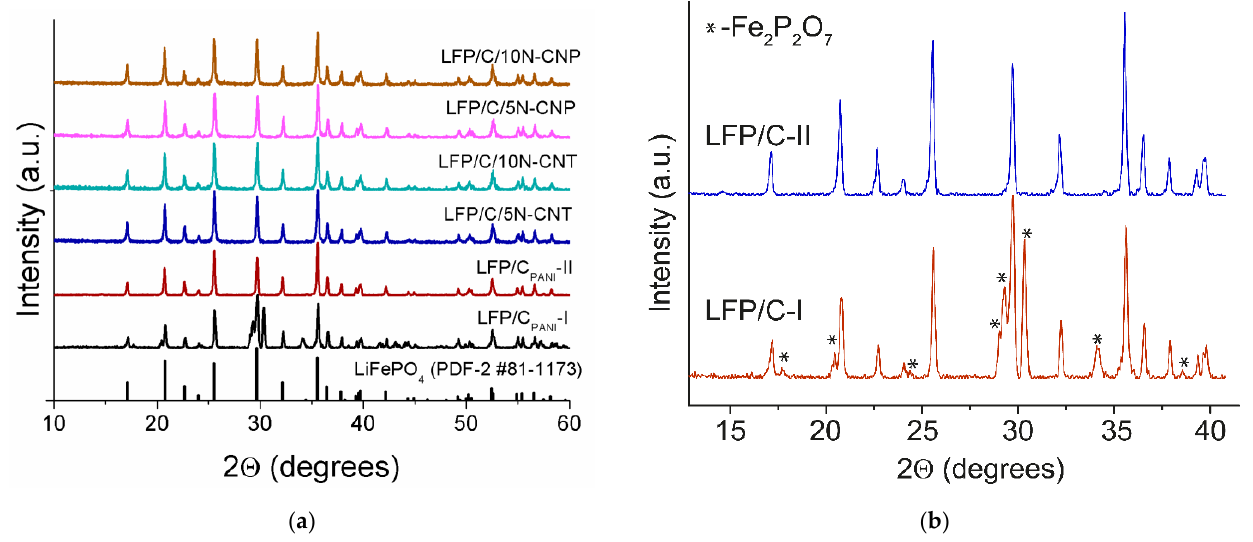
Figure 2. X-ray diffraction patterns of the composites: LFP/C PANI -I, LFP/C PANI - II, LFP/С/5N -CNT, LFP/С/10N -CNT, LFP/С/5N - CNP, and LFP/С/10N -CNP ( a ). Portions of XRD patterns of LFP/C PANI -I and LFP/C PANI -II in the region of 2 Θ = 15–40 ◦ ( b ).